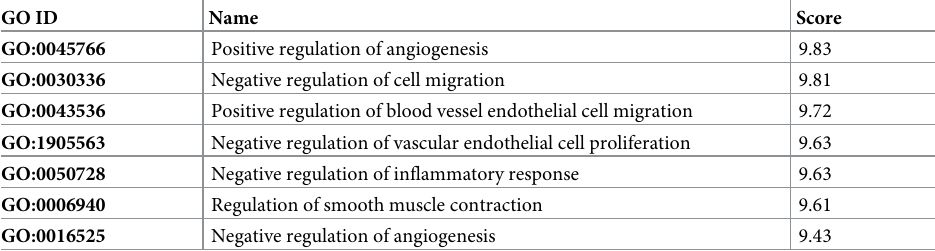
Table 3. Biological processes identified in both the enrichment analysis results and